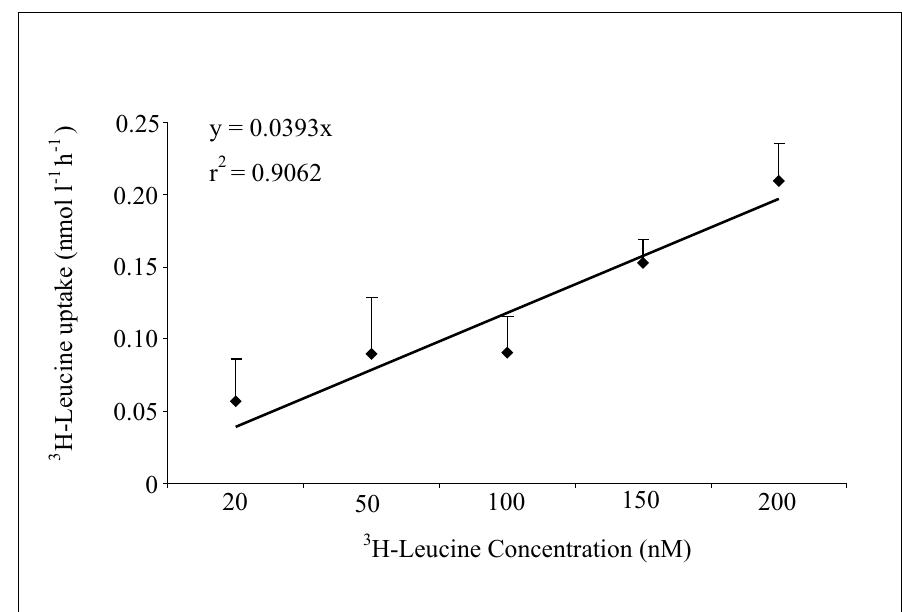
Fig. 2 – Leucine uptake versus leucine concentration in water samples from Lake Stechlin. Vertical bars represent the average (n=5) + standard deviation.